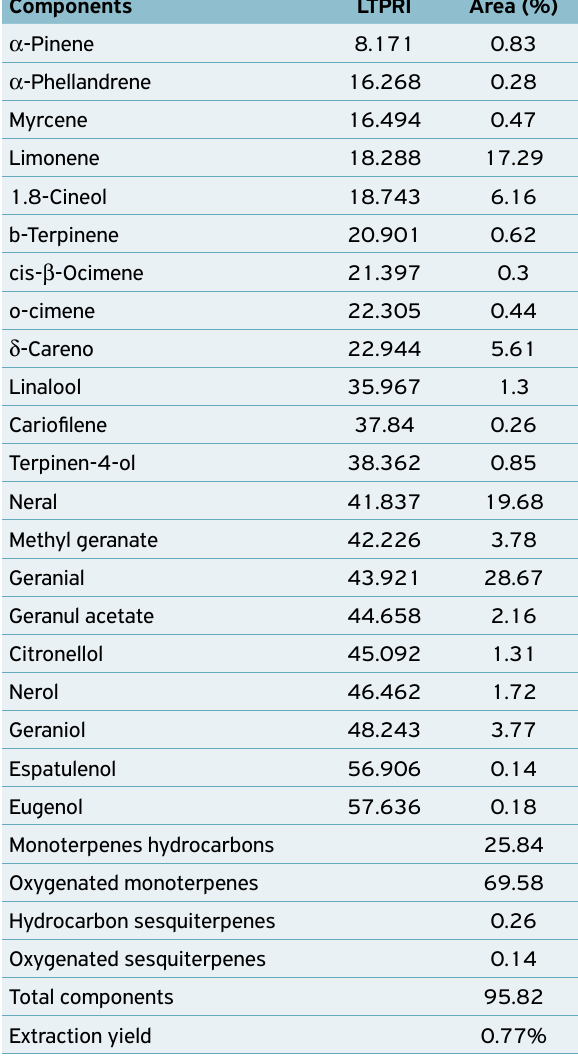
Table 1. Chemical composition of the essential oil dried leaves of Eucalyptus staigeriana (EO dl ES) by gas chromatography‑ mass spectrometry (GC‑MS) and gas chromatography‑flame ionization detector